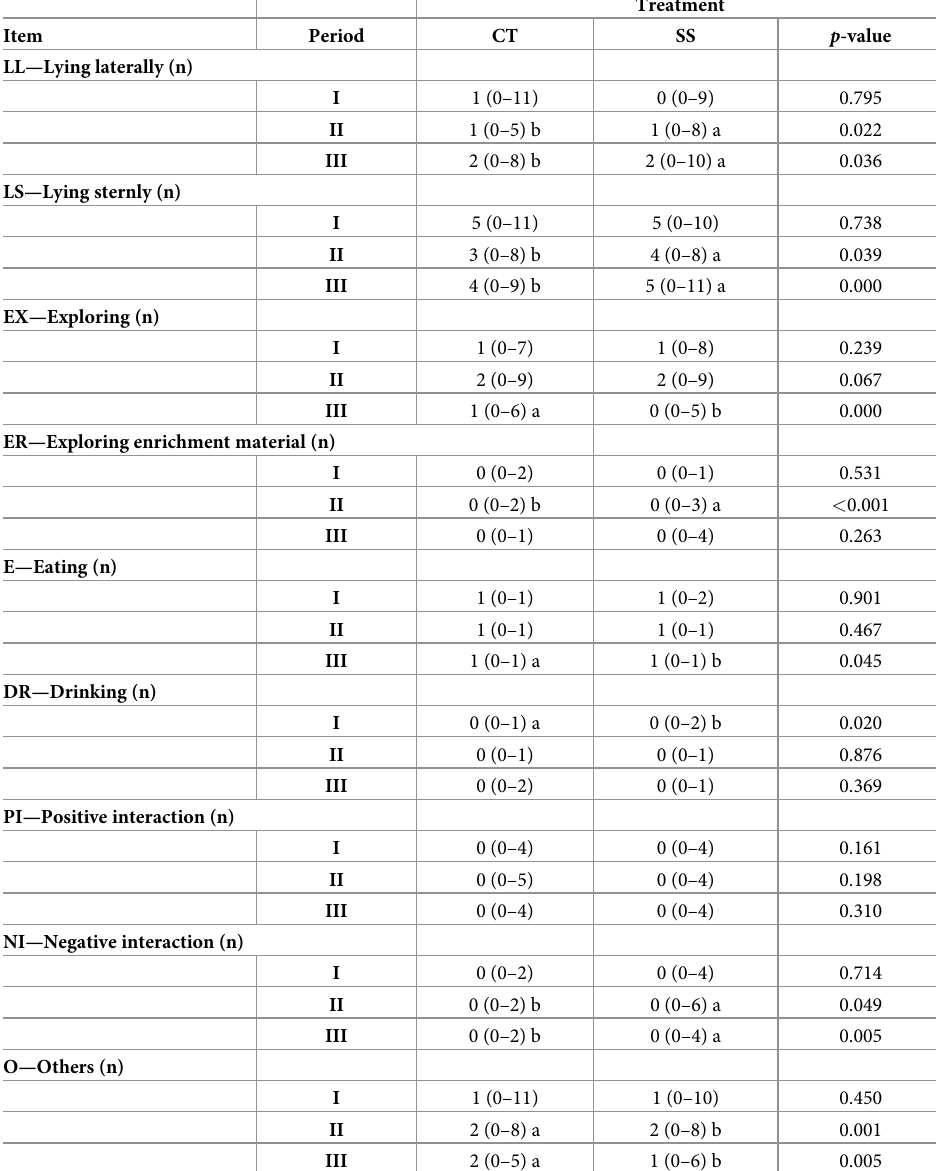
Table 6. Frequency of observed behaviors of pigs at growing and finishing phases obtained through the scan sam- pling method and presented as MD (median / min—max) and absolute